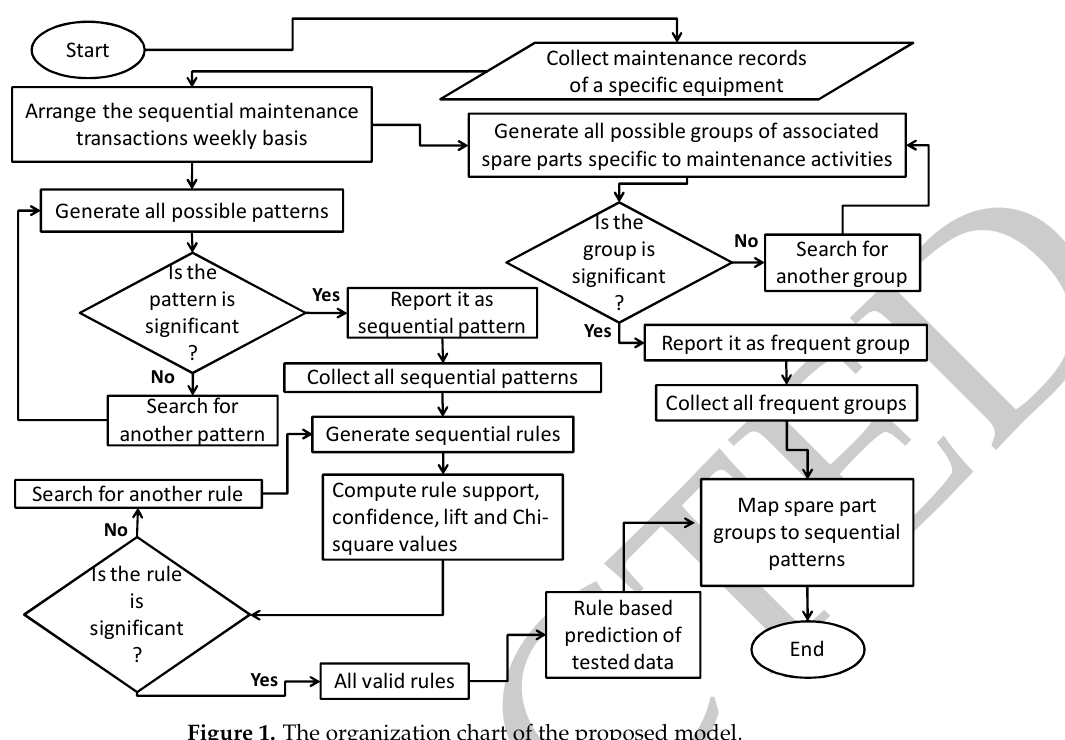
Figure 1. The organization chart of the proposed model.